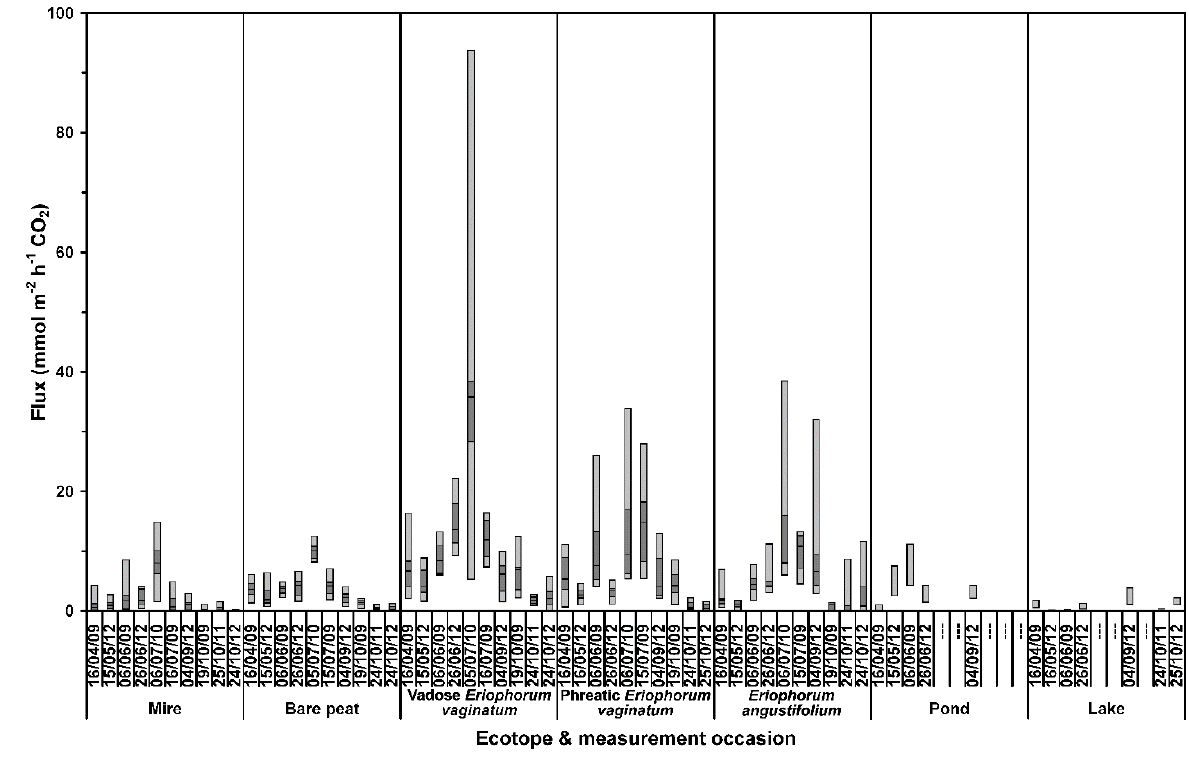
Figure 2. CO 2 fluxes to the atmosphere (mmol m -2 h -1 ) within the ecotopes, shown in quartiles (bars) and listed in order of seasons.